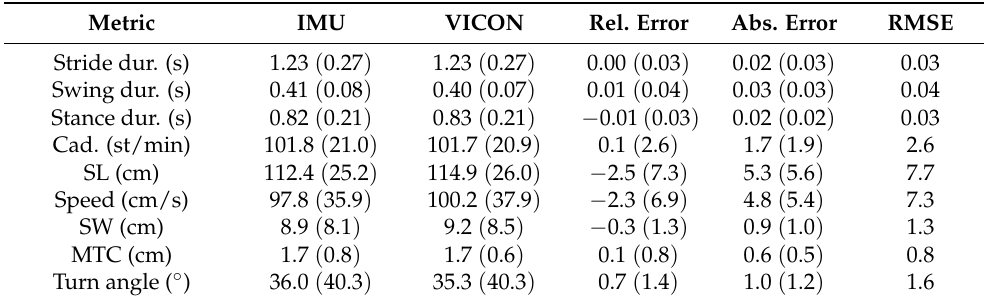
Table 3. Performance on the development set, using the best combination of methods and parameters ( n = 2788 strides). Shown are mean values (standard deviation) and RMSE.